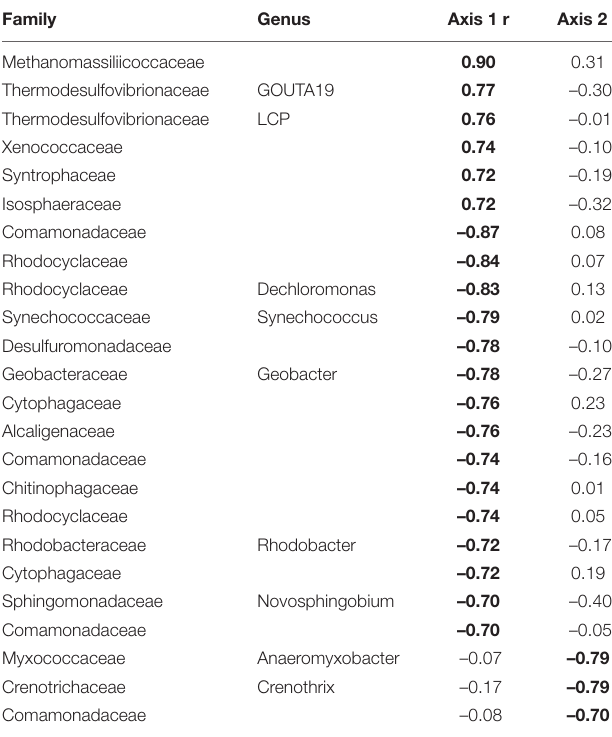
TABLE 4 | Axis loadings for PCA sediment microbial